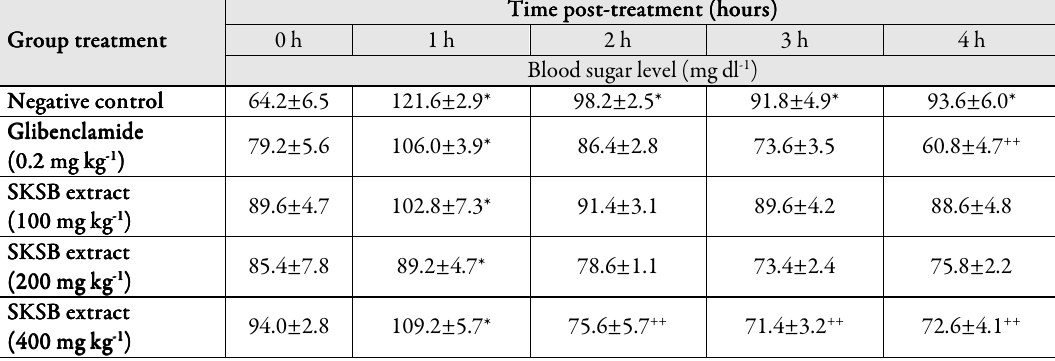
Table 2. Effects of SKSB extract on Glucose challenge test (Oral glucose tolerance test, OGTT) Group treatment